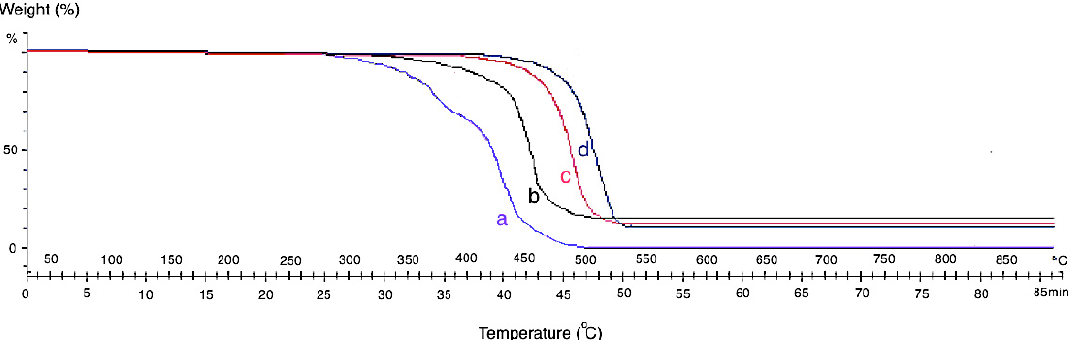
Figure 4. Themogravimetric analysis (TGA) analysis of ( a ) neat CF and CF-CNF at ( b ) 450 °C, ( c ) 550 °C, and ( d ) 650 °C.